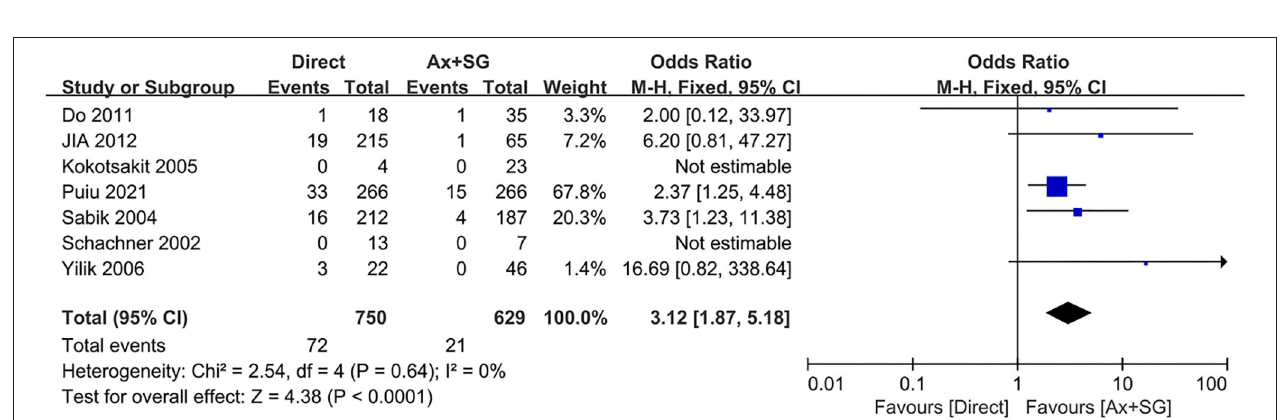
FIGURE 2 | Neurological dysfunction in direct artery cannulation vs. side-graft artery cannulation.